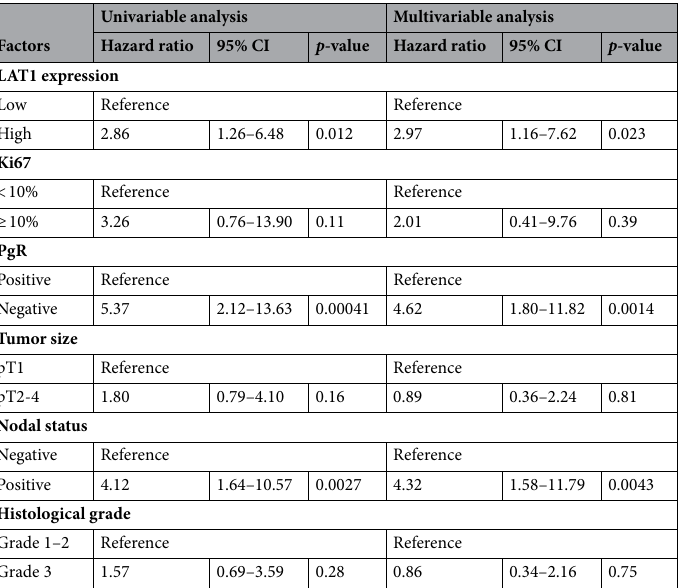
Table 3. Survival analysis based on clinicopathological factors, including LAT1 protein expression, in ER-positive/HER2-negative patients. LAT1 L-type amino acid transporter 1, ER estrogen receptor, PgR progesterone receptor, HER2 human epidermal growth factor receptor